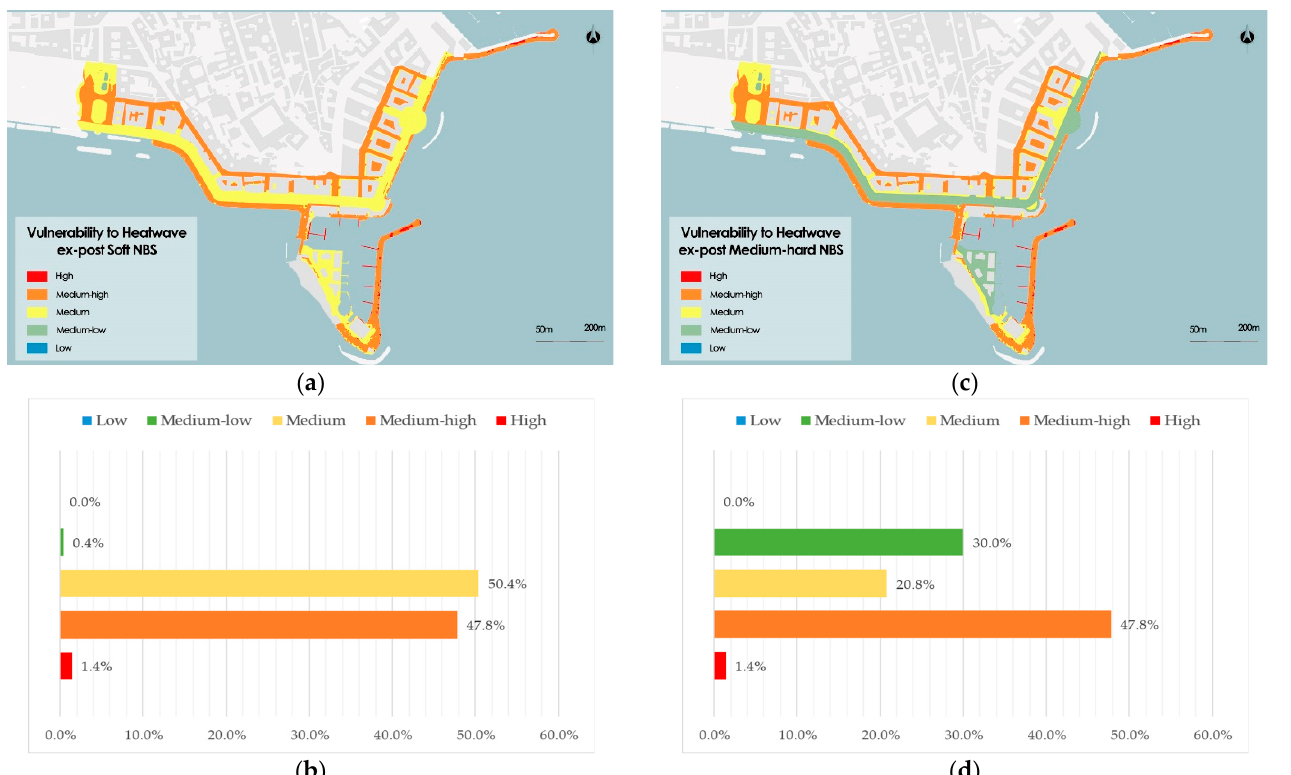
Figure 12. ( a ) Map of vulnerability to HW with the integration of soft NBS; ( b ) histogram of vulner- ability to HW with the integration of soft NBS; ( c ) map of vulnerability to HW with the integration of medium-hard NBS; ( d ) histogram of vulnerability to HW with the integration of medium-hard NBS.